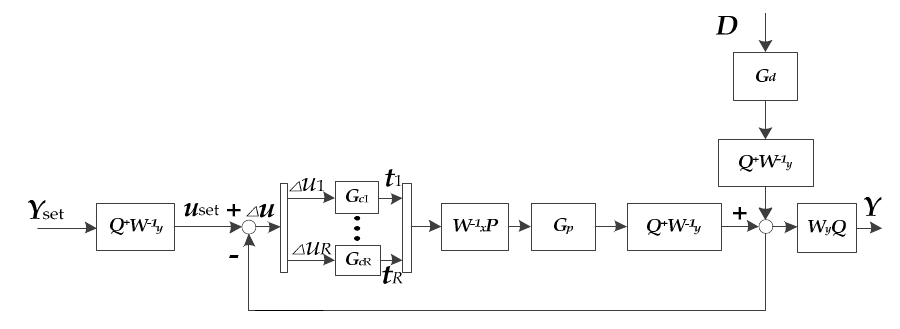
Figure 2. PLS control framework proposed by Kaspar and Ray.